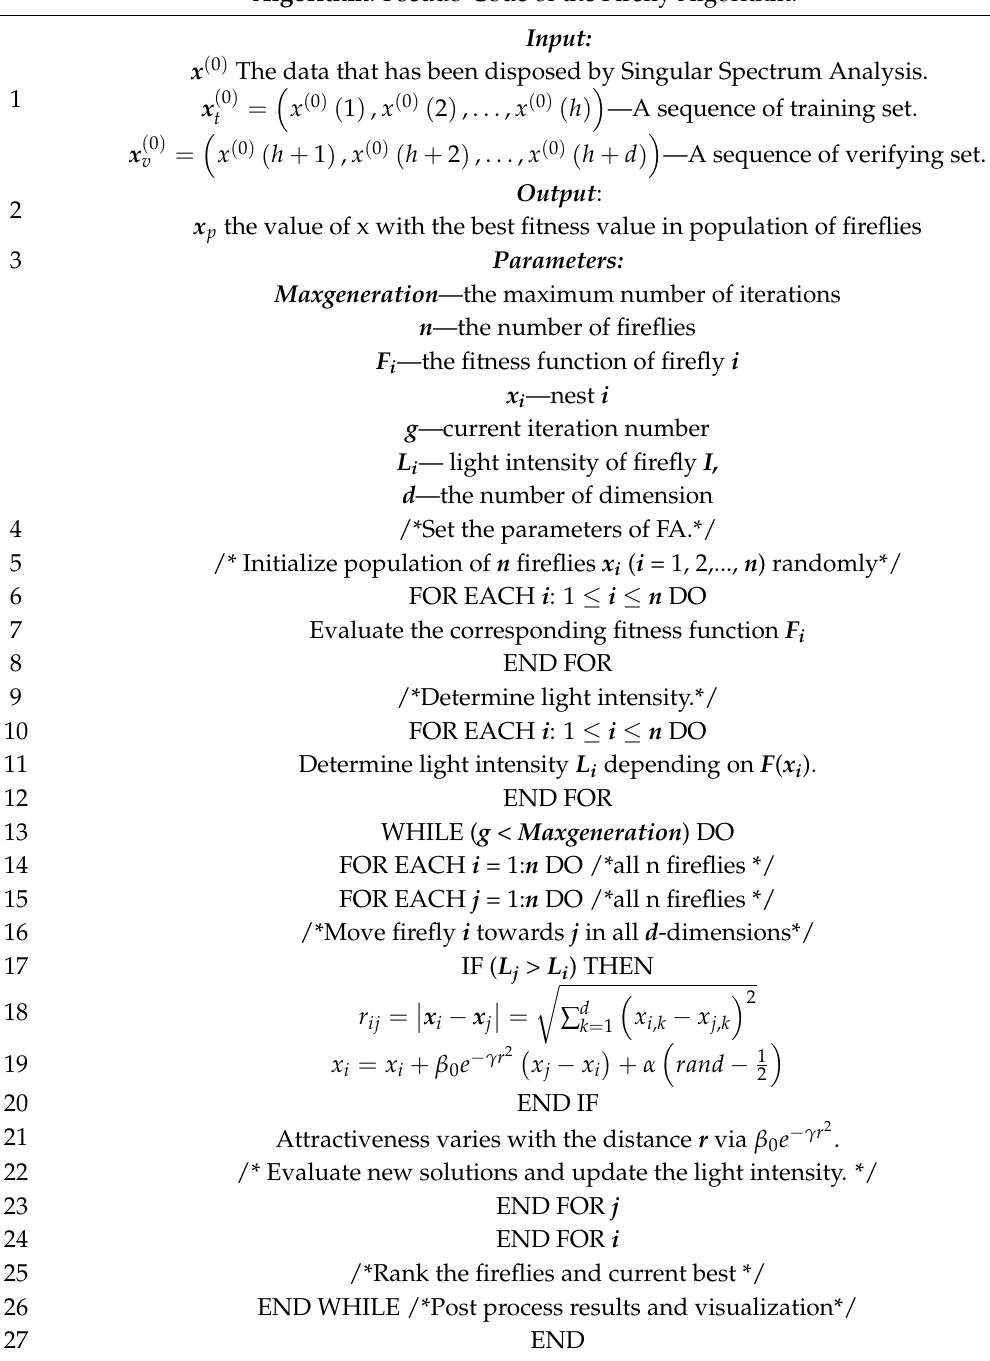
Algorithm : Pseudo-Code of the Firefly